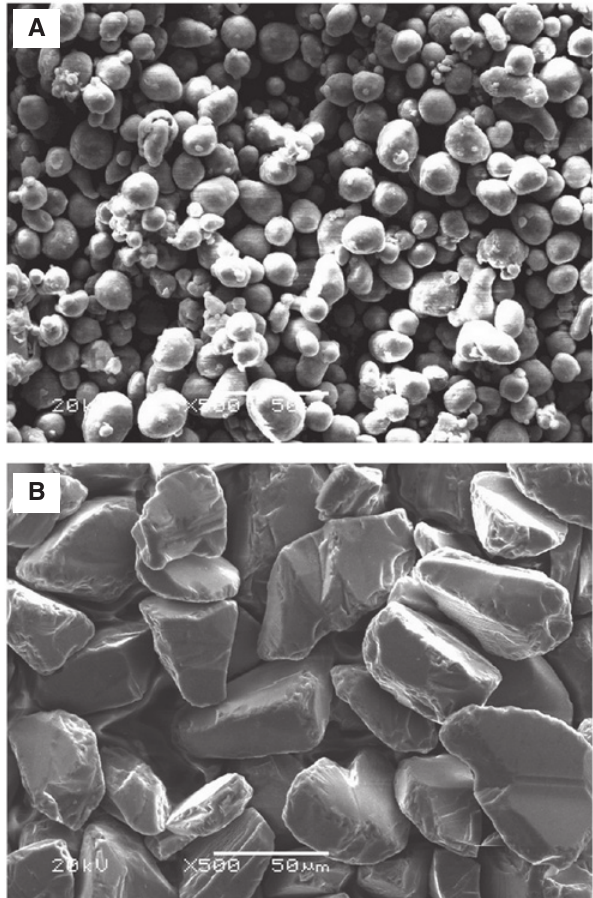
Figure 1 SEM micrographs showing morphologies of as-received powders: (A) 2024Al, (B)